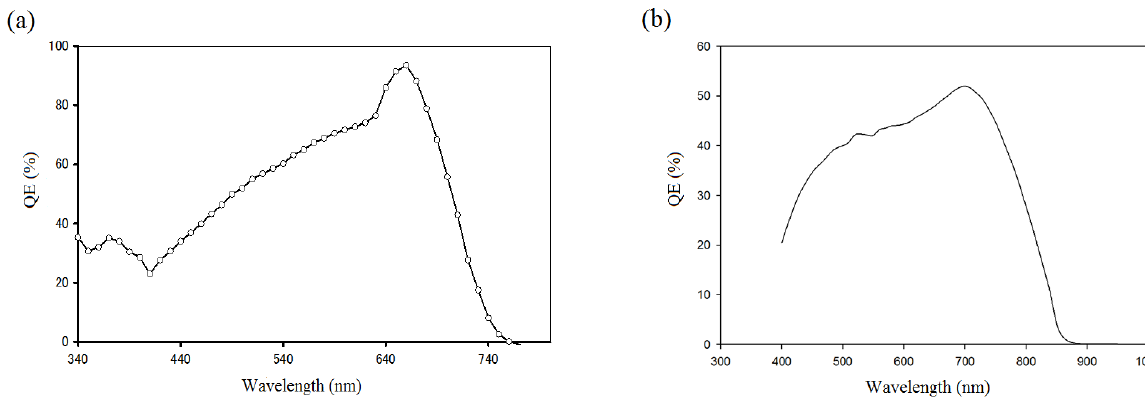
Figure 11. Typical QE curves measured for devices fabricated from the first growth ( a ) and the second growth ( b ). The losses in both blue and red ends are evident for the first set of devices, but the collection at the rear has improved showing the red-end cut-off moving from ~740 nm to ~870 nm.